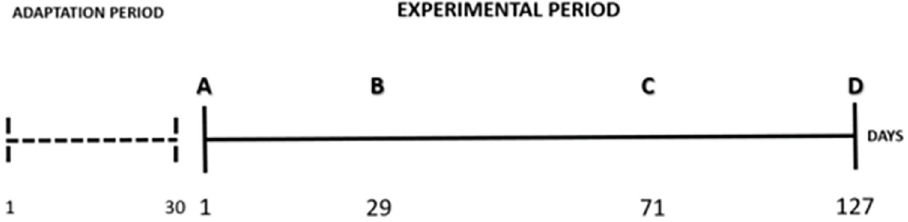
Fig 1. Experiment timeline. This study was conducted for 157 days, with 30 days for adaptation and 127 days for experimental protocol, following this timeline sequence: A: beginning of the experiment and first mix performed (distribution of control (CT) and stress (SS) groups); B: representation of the second mix performed (females’ mix); C: representation of the third mix performed (barrows’ mix); D: end of the experiment and pigs’ slaughter.